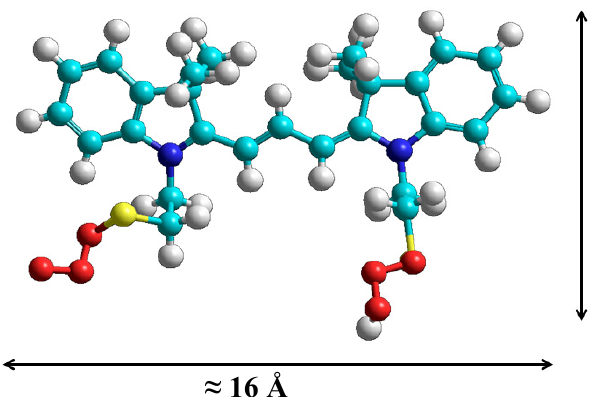
Figure 4. Structure of the 3,3'-di(2-sulfoethyl)-indocarbocyanine dye obtained with the use of HyperChem, version 6. The approximate dimensions of the trans isomer are